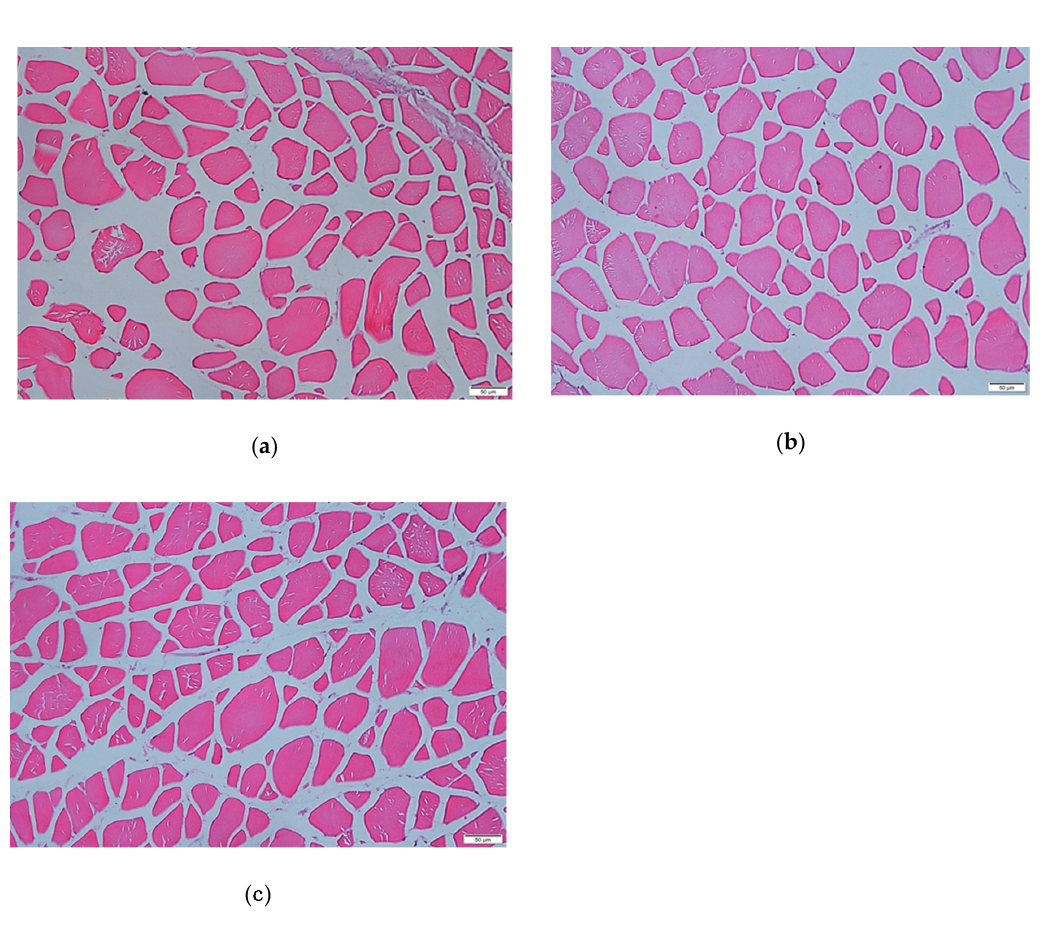
( P < 0.05). The protein content (Figure 3A) and RNA/protein ratio (Figure 3B) gradually increased for